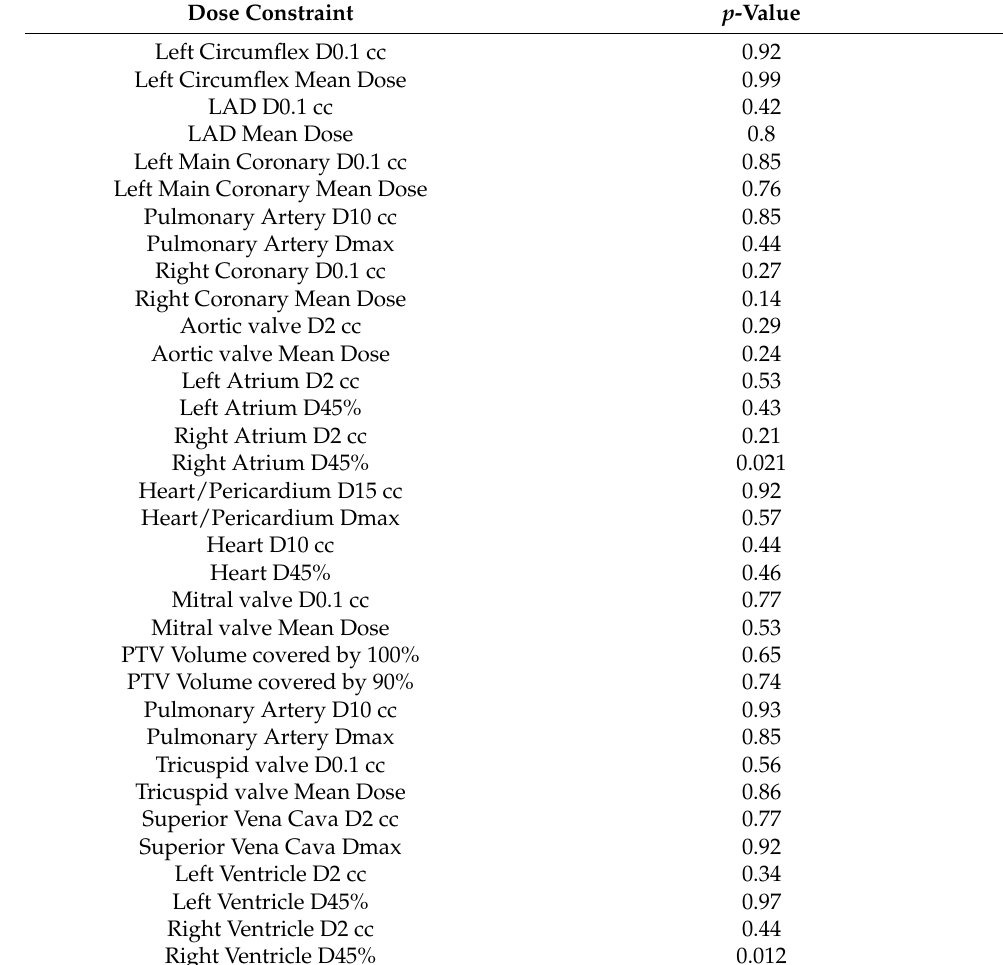
Table 3. Univariate Cox